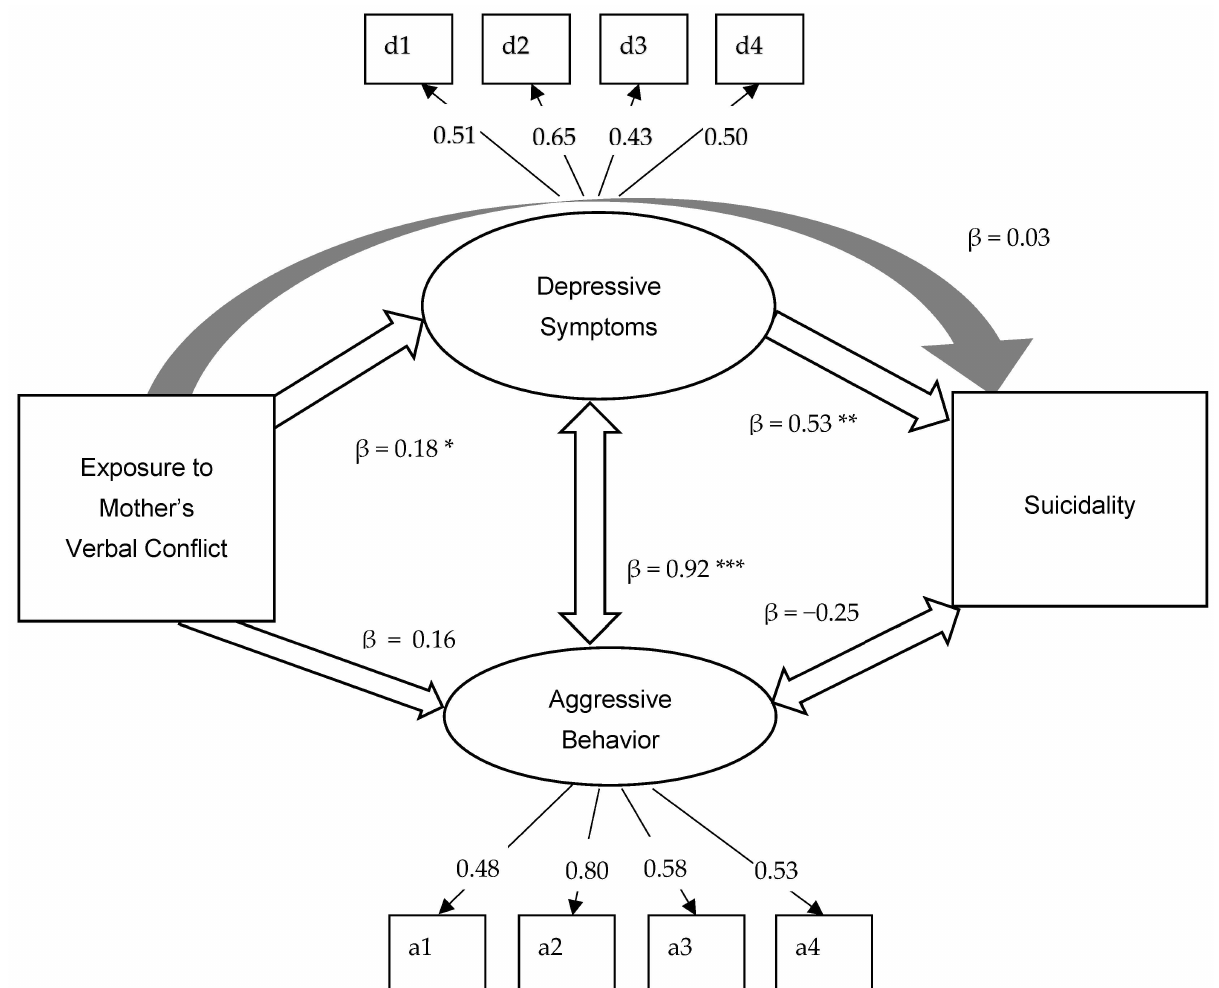
Figure 2. Results from the SEM Analyses. Note: Model fit: χ 2 (df = 47) = 87.1, p = 0.002; CFI = 0.93; TLI = 0.95; RMSEA = 0.04; SRMR = 0.08. The model controlled for adolescents’ age, sex, race, family structure, and whether receiving free lunch. * p < 0.05 ** p < 0.01 *** p <